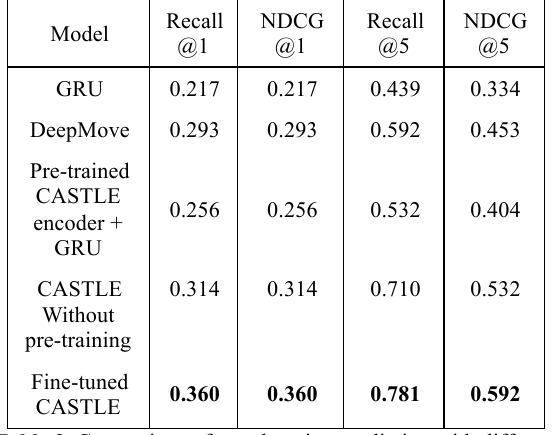
Table 3. Comparison of next location prediction with different methods.